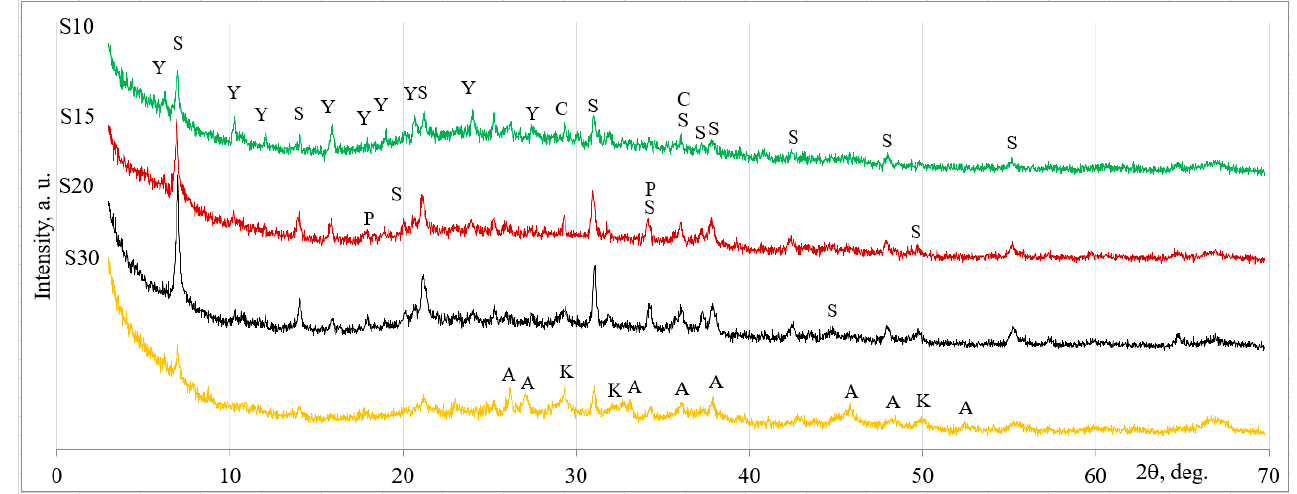
Figure 1. X-ray diffraction patterns of hardened zeolitic materials after 7 days. S, straetlingite Ca 2 Al((AlSi) 1.11 O 2 )(OH) 12 (H 2 O) 2.25 (80–1579); P, portlandite Ca(OH) 2 (44–1481); A, aragonite CaCO 3 (3–893); K, calcium silicate hydrate Ca 1.5 Si O 3.5 · x H 2 O (33–306); C, cal-cite CaCO 3 (72–837); Y, faujasite Al 60.352 · Si 139 · O 371.52 · H 5.984 (73–2313).